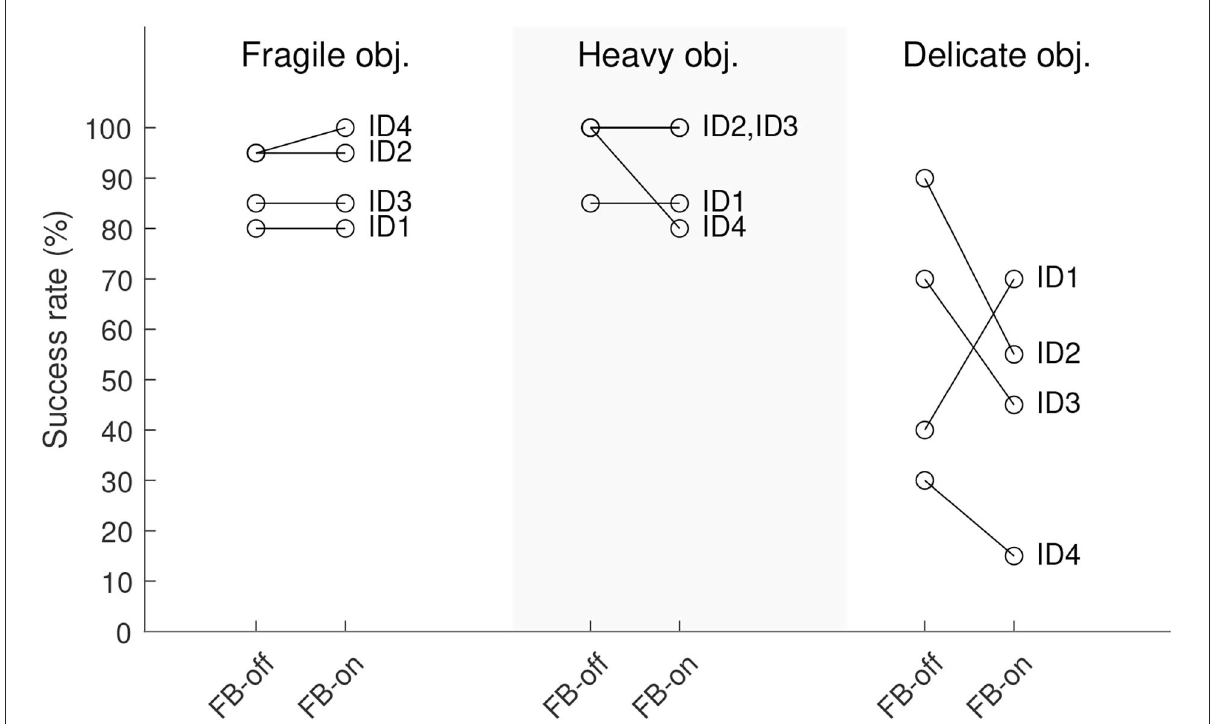
TABLE 4 Linear mixed effect model of the time needed for manipulation tasks. Manipulation Fixed effect